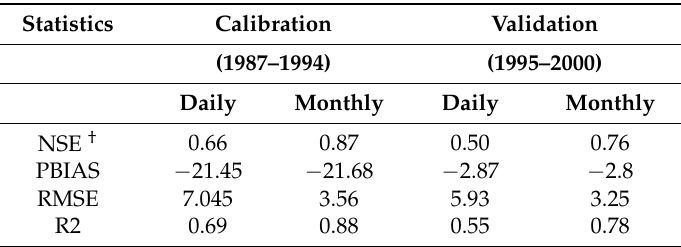
Table 2. Calibration and validation of stream flow simulated using Soil and Water Assessment Tool coupled with semi-automated